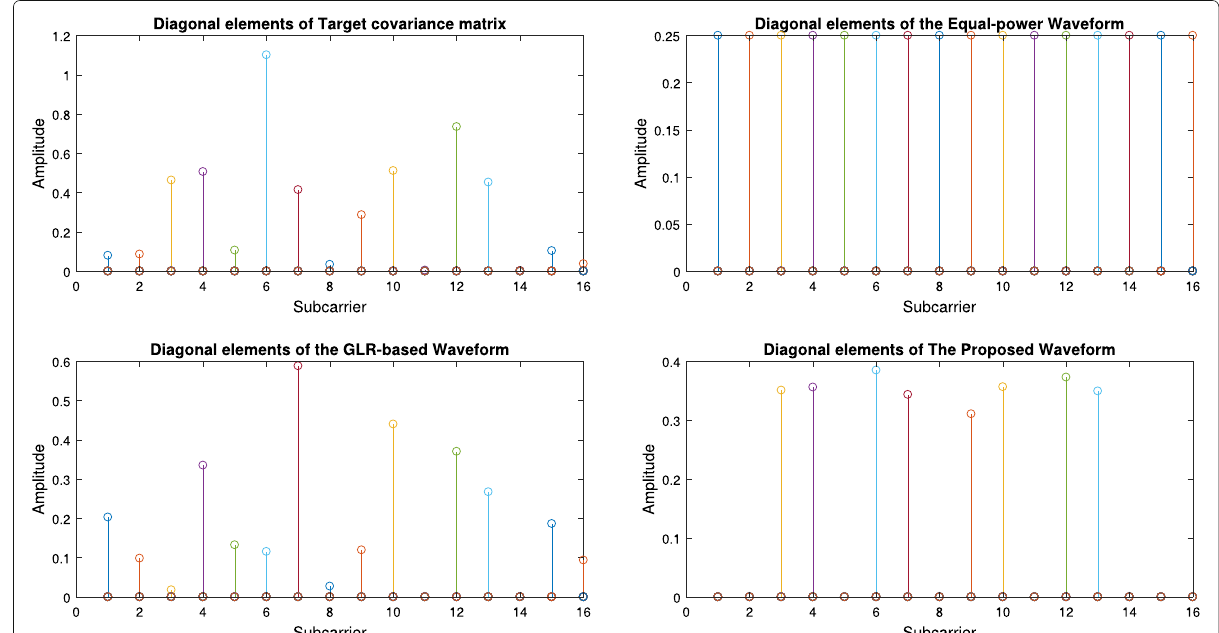
Fig. 5 Illustration of power allocation for different multicarrier waveforms. a Diagonal elements of target covariance matrix. b Diagonal elements of equal power waveform. c Diagonal elements of GLR-based waveform. d Diagonal elements of the proposed waveform ( L = 16, P t = 10 dBW )